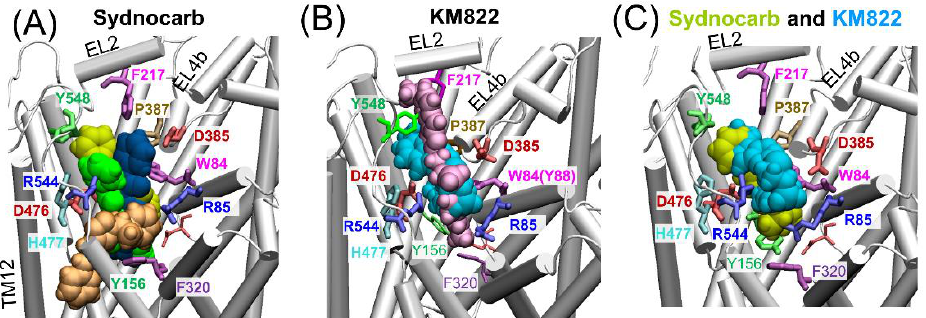
Figure 4. Comparison of MD-resolved ligand binding poses. ( A ) Sydnocarb-binding poses captured by four independent MD runs. Light orange, green, yellow, and dark blue vDW balls display representative poses, stabilized in MD simulations Run1, Run2, Run3, and Run4. Detailed results are shown in Figure 3 (Run1 and Run2) and Figure S3 (Run3 and Run4). Note that three MD runs (Run2, Run3, and Run4) converged on a similar site. The binding pose resolved by Run1 differed significantly. ( B ) KM822-binding poses captured by two independent MD runs. Cyan and mauve vDW balls showed representative KM822-binding poses, stabilized in MD simulations KM822-Run1 and KM822-Run2, respectively. Detailed simulation results are shown in Figure S4. ( C ) Resemblance of sydnocarb and KM822 binding. Yellow and cyan vDW balls showed a representative sydnocarb-binding pose stabilized in MD simulation Run3 (Figure S3A–D) and KM822-binding pose captured in KM822-Run1 (Figure S4A–C). Representative binding poses were taken at the end of the MD